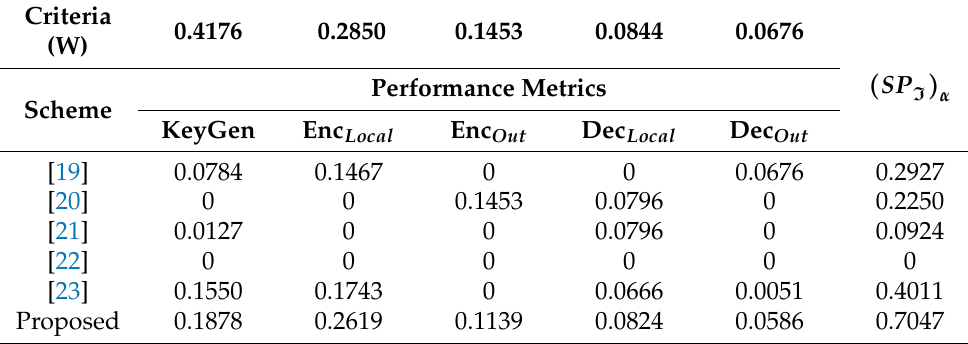
Table 9. Analysis results of the aggregate ( P I ) .